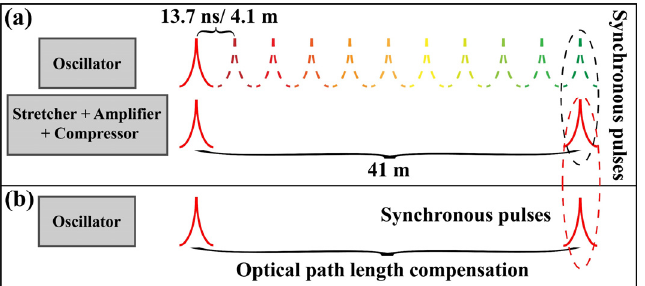
Figure 3. Synchronous pulses ( a ) without and ( b ) with optical path correction (curves in different colors represent different laser pulses).